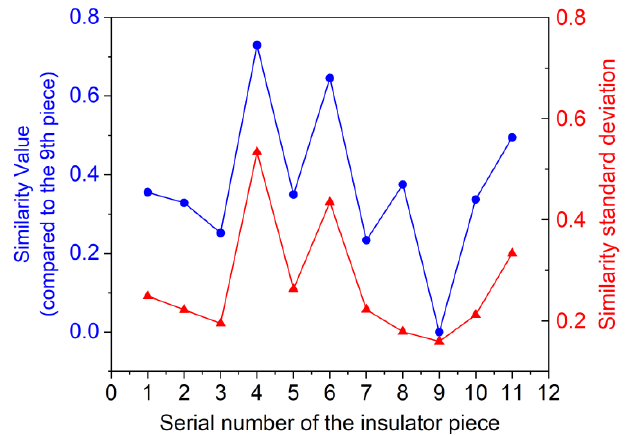
Figure 12. Similarity standard deviation and similarity value between pieces of normal insulator shown in Figure 11a.